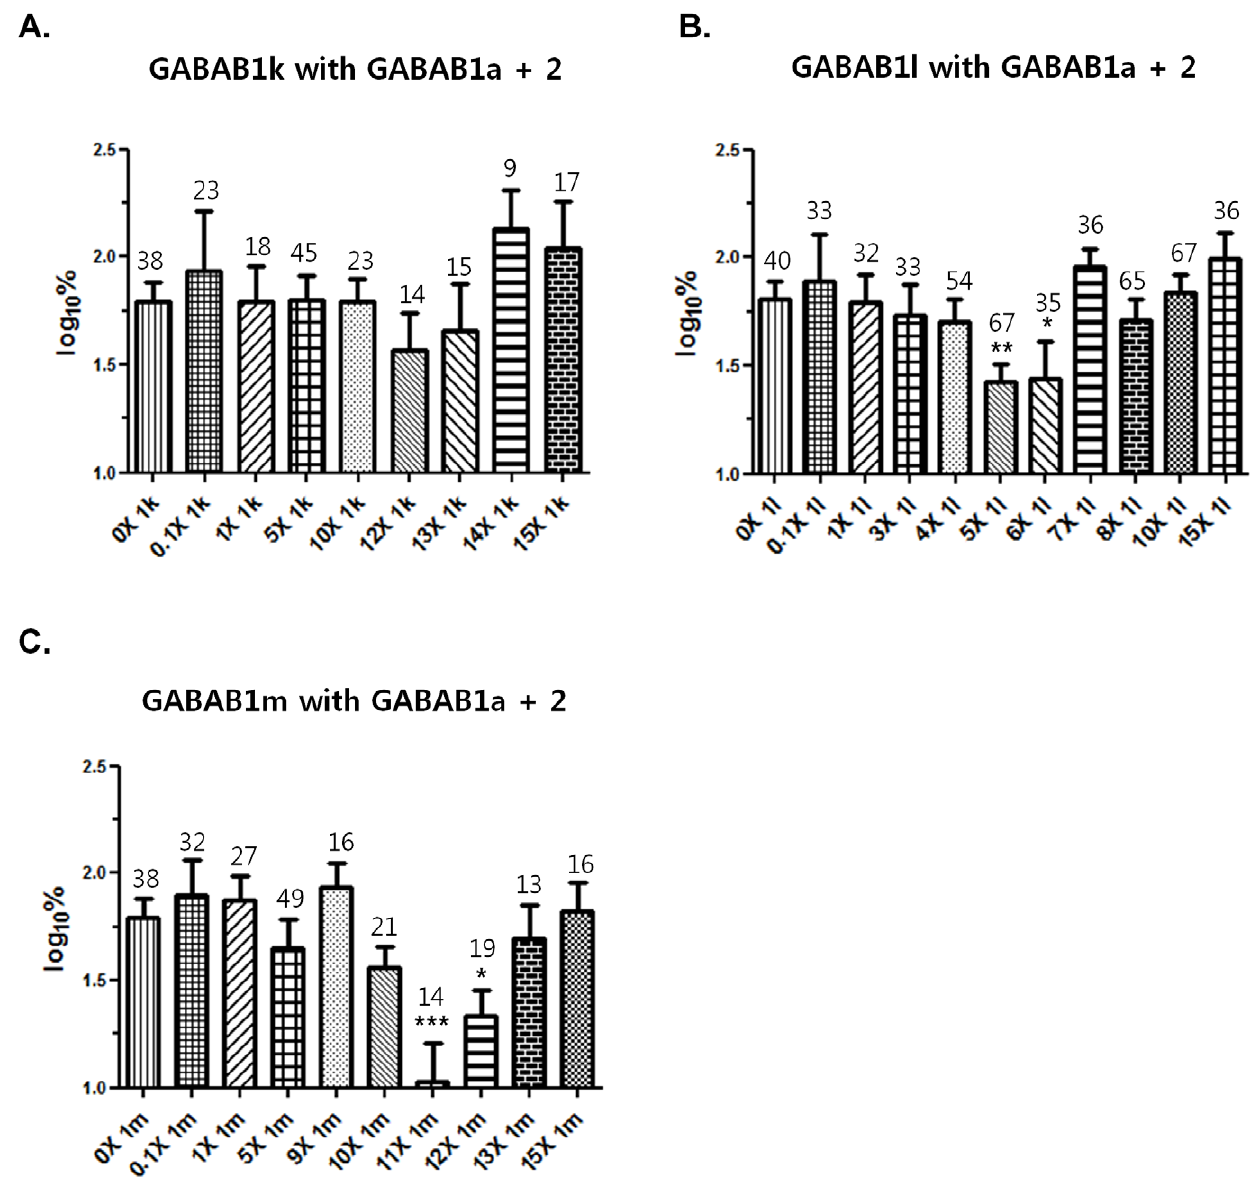
Figure 6. The functional effects of three novel human isoforms, GABAB1k, l, and m. Inhibitory effects were measured in Xenopus oocytes 5 days after injecting GABAB1a, GABAB2 cDNA and GIRK1, GIRK2 cRNA along with GABAB1k, l, or m cDNA. For vector controls, vectors were injected in the same amounts as used for the isoforms. Isoform and vector injection amounts varied from 0 to 15 times of GABAB1a injection amount. Used GABA concentration was 3 mM, an approximate maximum response concentration. For each batch, individual GIRK currents from isoform injected oocytes were normalized to percentage by the average vector control current. For nonparametric tests, the individual percent values were changed to log 10 . After one-way ANOVA and Dunnett’s tests, one-tailed unpaired Student’s t-tests were performed between no isoform injected groups and the isoform injected groups. A. GABAB1k had no inhibitory effect. B. GABAB1l data showed significant differences by ANOVA and Dunnett’s tests (p=0.0058), and caused significantly decreased GIRK currents at 5 6 and 6 6 GABAB1l (**p=0.0014 and *p=0.0229, respectively). C. ANOVA and Dunnett’s tests showed the significant differences of GABAB1m data (p=0.0040). GABAB1m showed significant decreases at 11 6 and 12 6 GABAB1m (***p=0.0003 and **p=0.0064, respectively). The numbers of recorded oocytes are shown above the bars by each group. Data are expressed as the mean 6